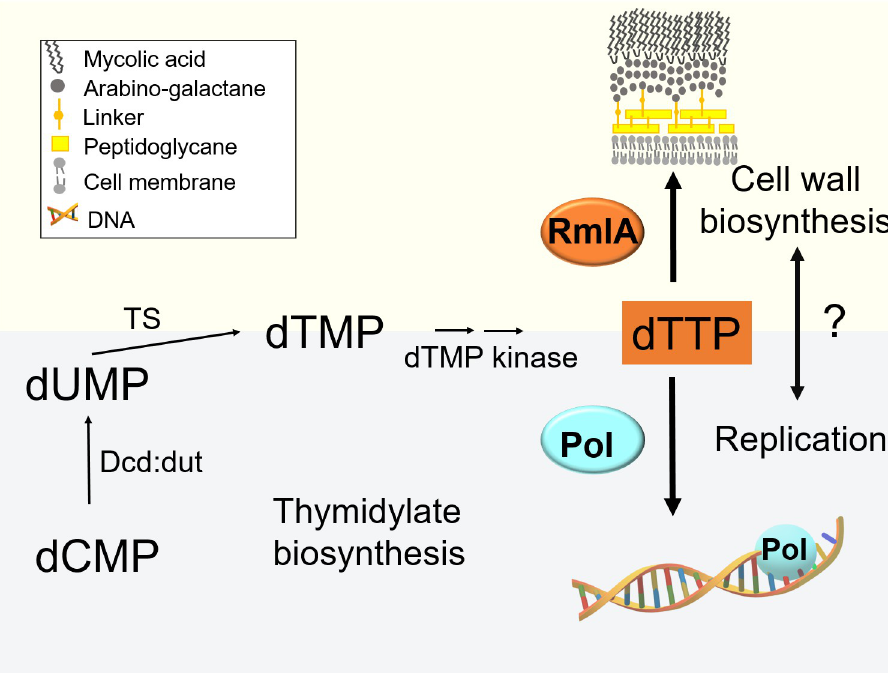
Fig 1. Hypothesis: A dual role of thymidylate biosynthesis in mycobacterium. In mycobacteria, dUMP, the precursor for dTTP biosynthesis, is synthesized exclusively by dCTP deamination and coupled dUTP hydrolysis by Dcd:dut. dTTP is used not only for DNA replication by DNA polymerases but also by RmlA that uses this nucleotide for the first step of L-rhamnosyl biosynthesis, a critical step in cell wall biosynthesis. (Abbreviations: linker–L- rhamnosyl linker; Dcd:dut—bifunctional dCTP deaminase:dUTPase; TS–thymidylate synthase; RmlA—D-glucose- 1-phosphate thymidylyltransferase; Pol–DNA